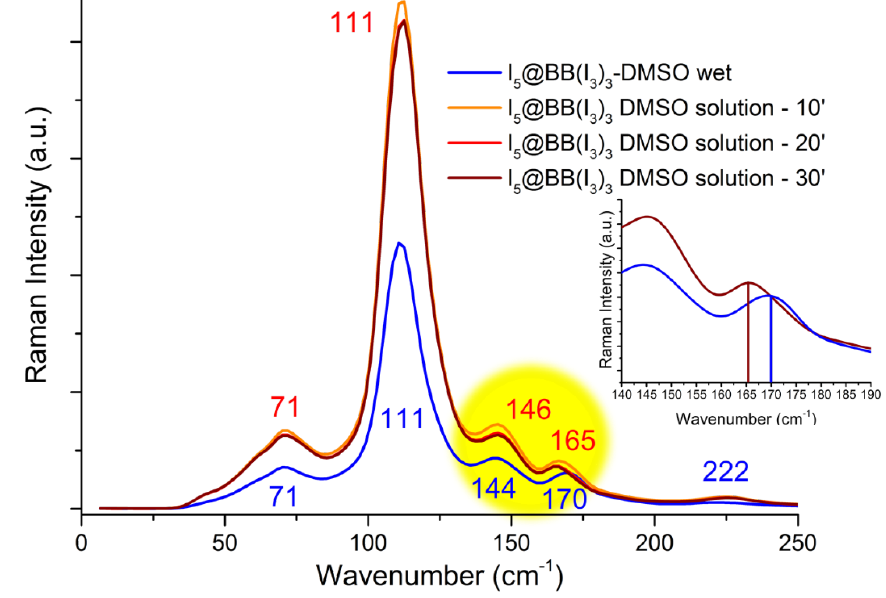
Figure 10. Variation of Raman spectra as I 5 @(BB)(I 3 ) 3 slowly dissolves in DMSO.